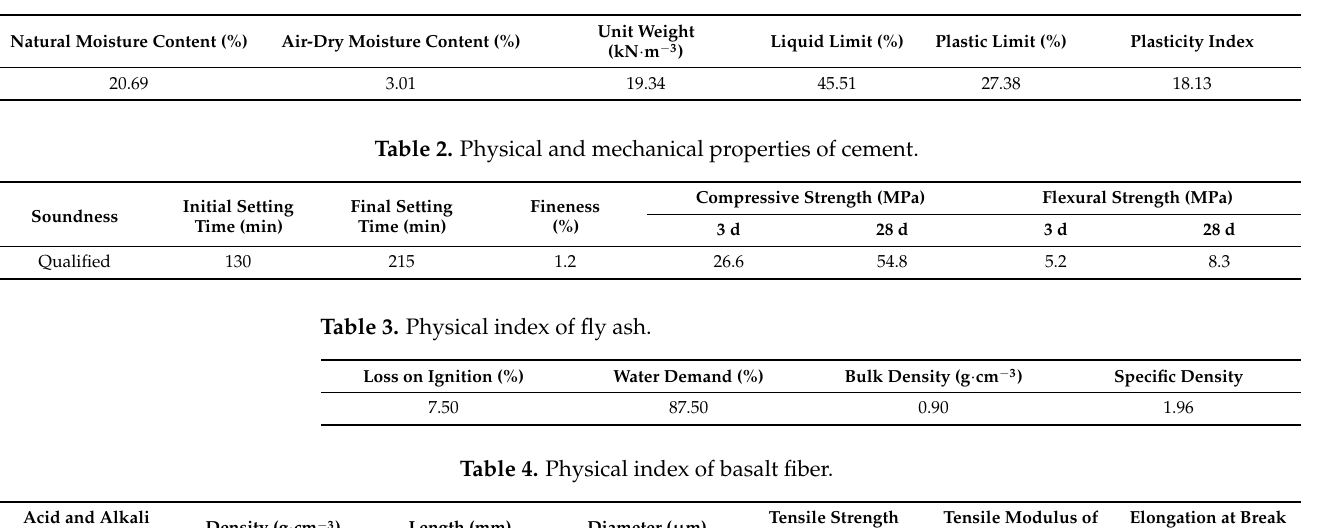
Table 1. Basic physical properties of the test soil.